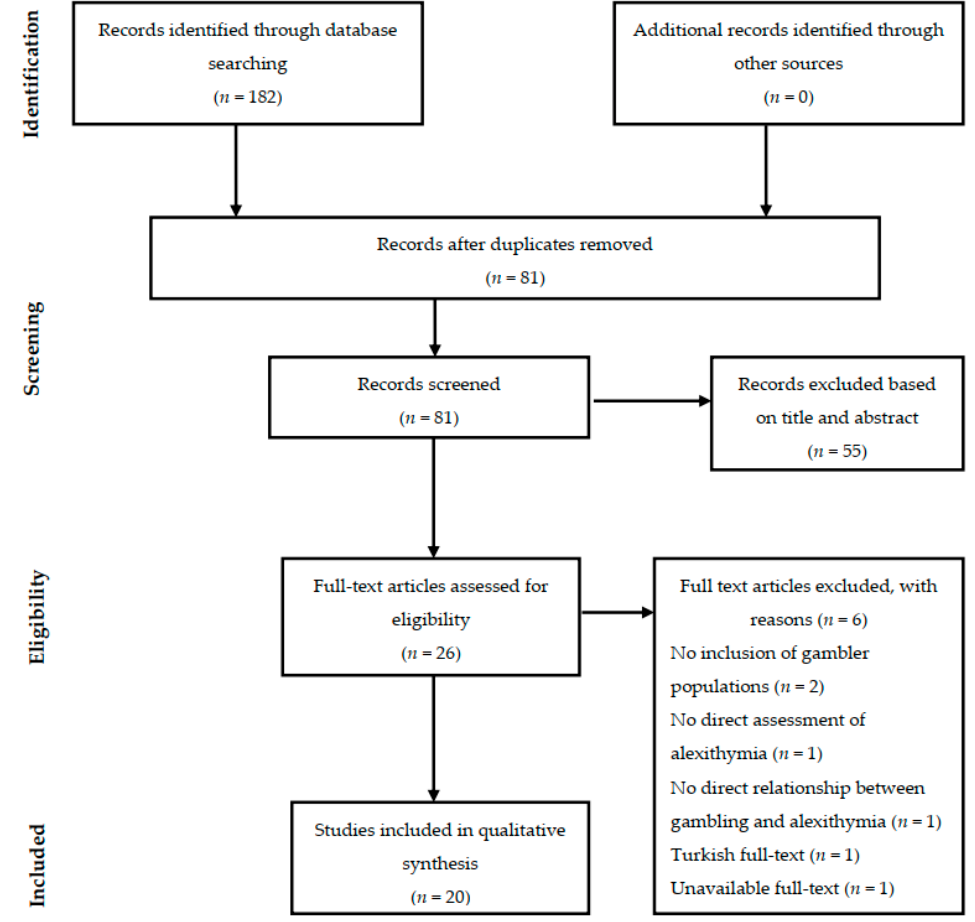
Figure 1. Flowchart of the systematic search.